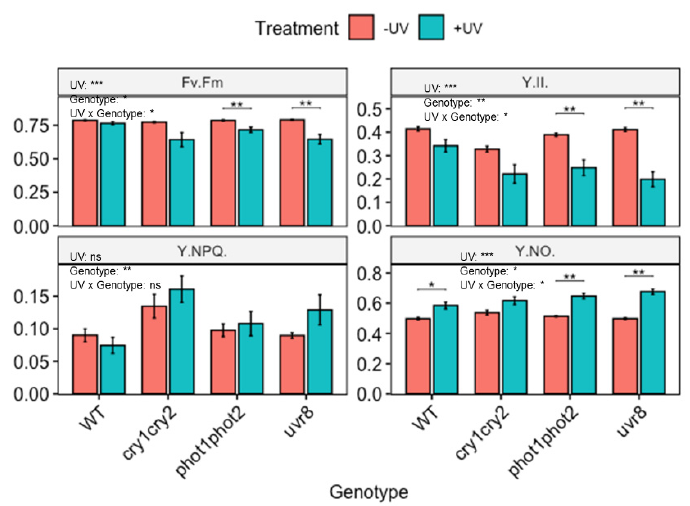
Figure 4. Photosynthetic efficiency of wild-type (WT) and photoreceptor deficient Arabidopsis thaliana (Col-0) exposed to UV; cry1cry2 (cryptochrome), phot1phot2 (phototropin) and uvr8 (UV-B photoreceptor). Plants were subjected to UV treatment for 3.75 h daily and harvested after 18 h on day 4. F v /F m : the maximum quantum efficiency of photosystem II (PSII); Y(II): the quantum efficiency of PSII under steady-state light conditions; Y(NO): yield of non-regulated non-photochemical energy dissipation and Y(NPQ): the yield of regulated non-photochemical energy dissipation. Bar plots show means and error bars indicate standard error for n = 5. The text in each panel shows the outcome of a two-way ANOVA across treatment and exposure duration. The stars above pairs of bars show the outcome of t -tests between the UV treatments. In both cases * ( p < 0.05), ** ( p < 0.01) and *** ( p < 0.001) depict significant differences with ns depicting a non-significant difference.